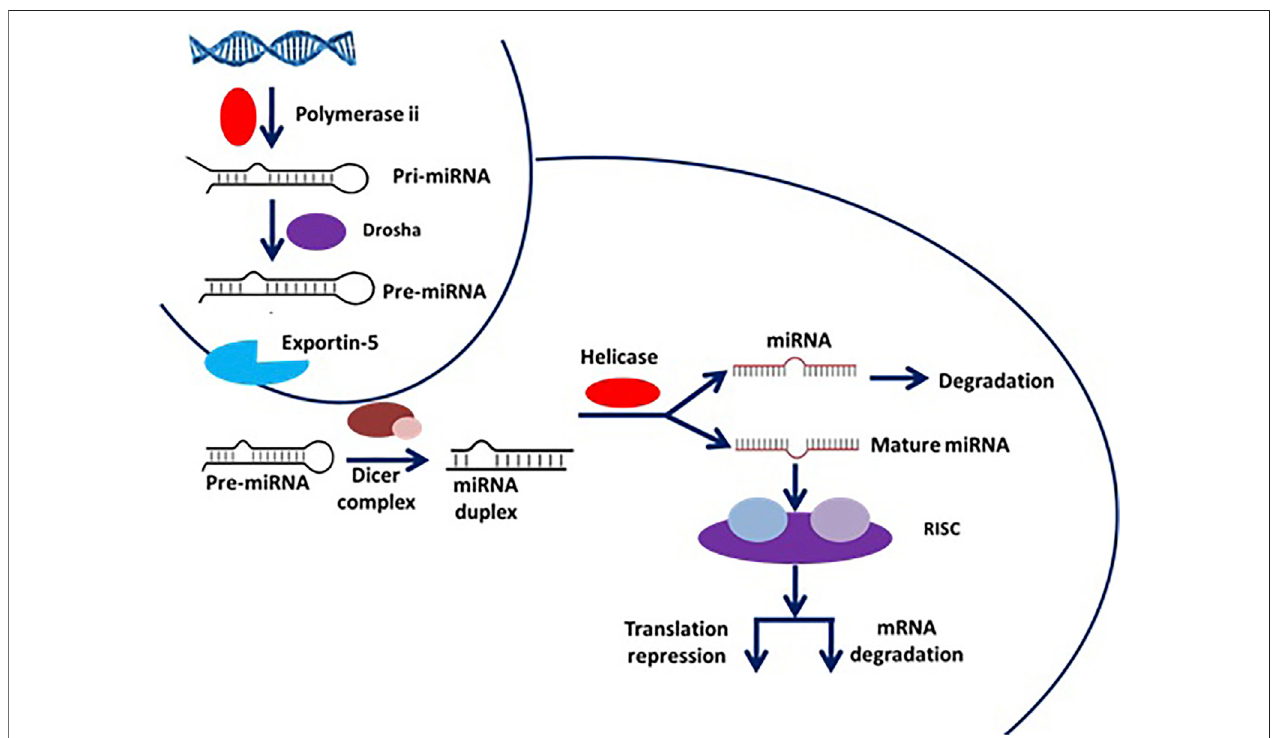
FIGURE 13 | Mechanistic pathway of miRNA formation from premature miRNA.